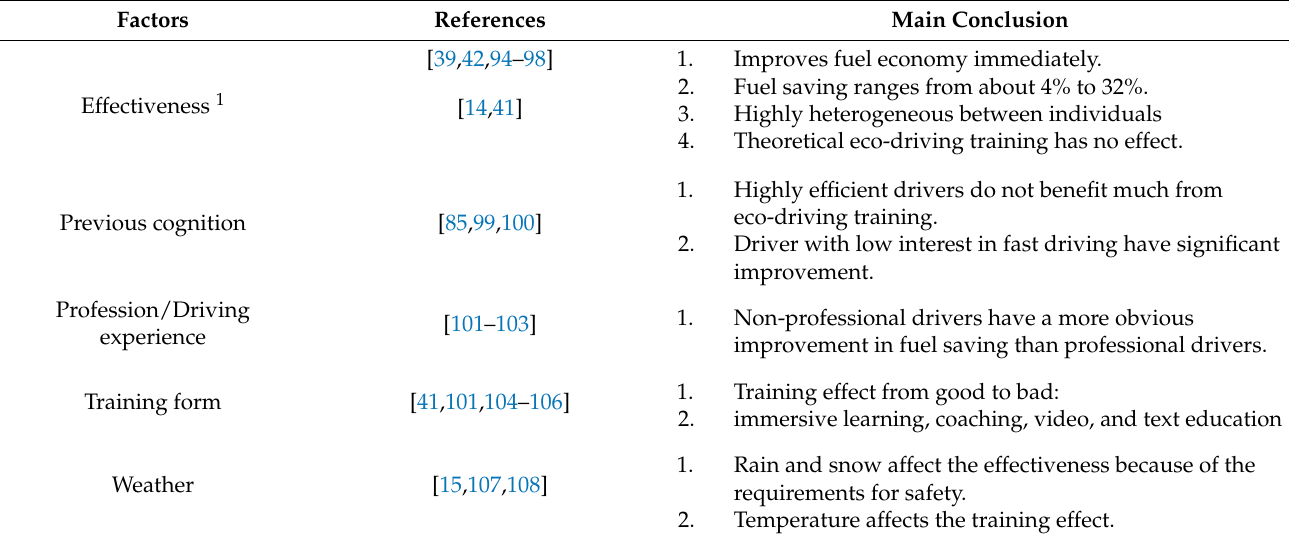
Table 2. Factors that influence the effectiveness of eco-driving training and